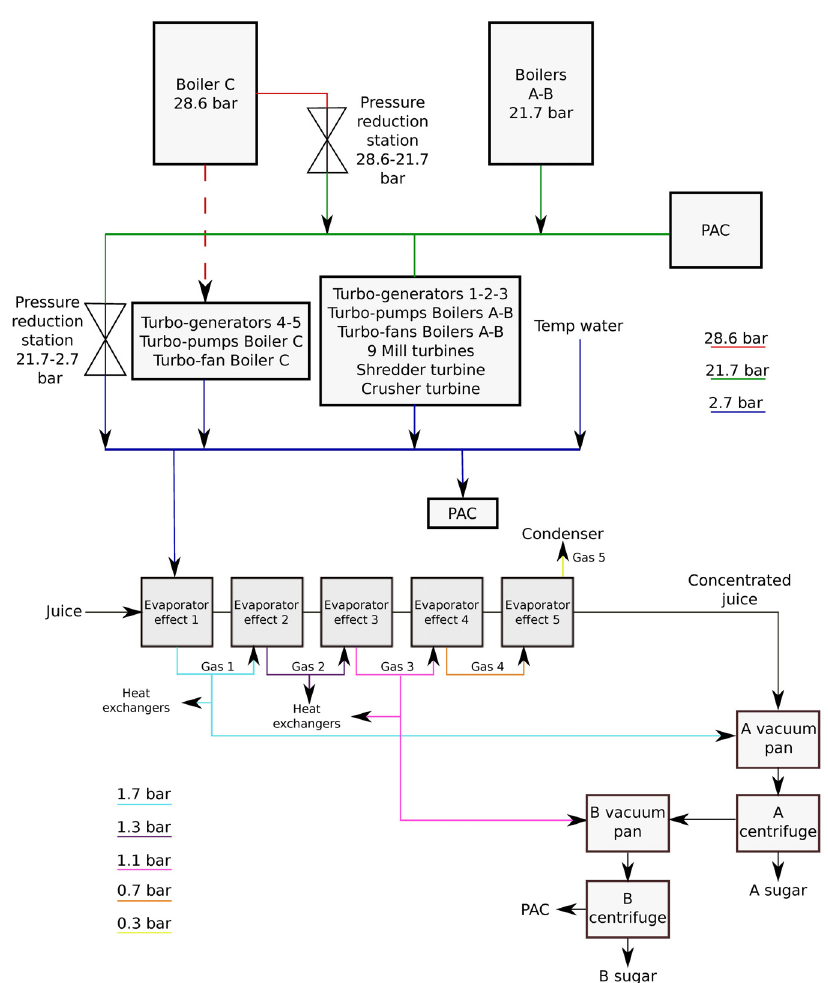
Figure 2. The cogeneration cycle in a sugarcane milling